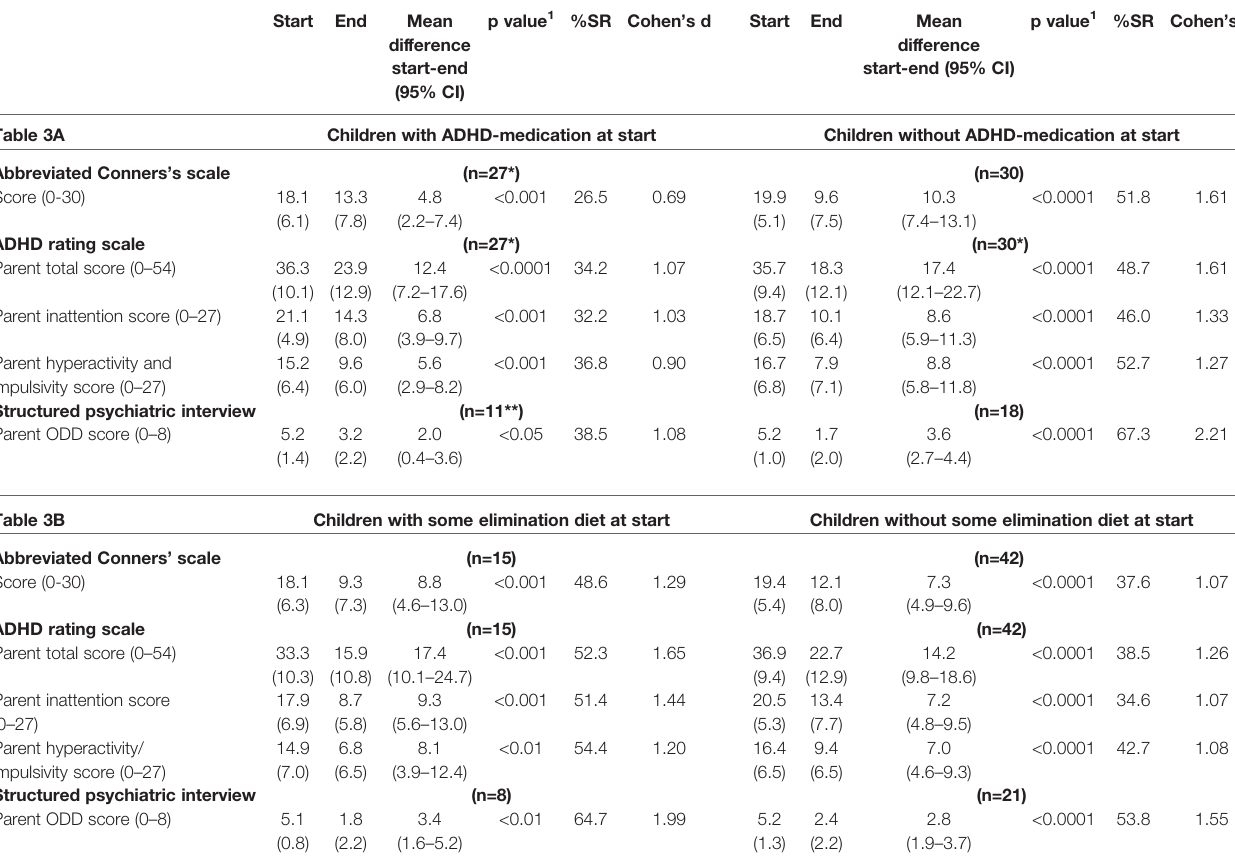
TABLE 3 | Parent measurements at start and end of the few-foods diet (last observation carried forward) in groups of children with and without attention-de fi cit/ hyperactivity disorder (ADHD) – medication (Table 3A) and with and without some elimination diet (Table 3B) at start.